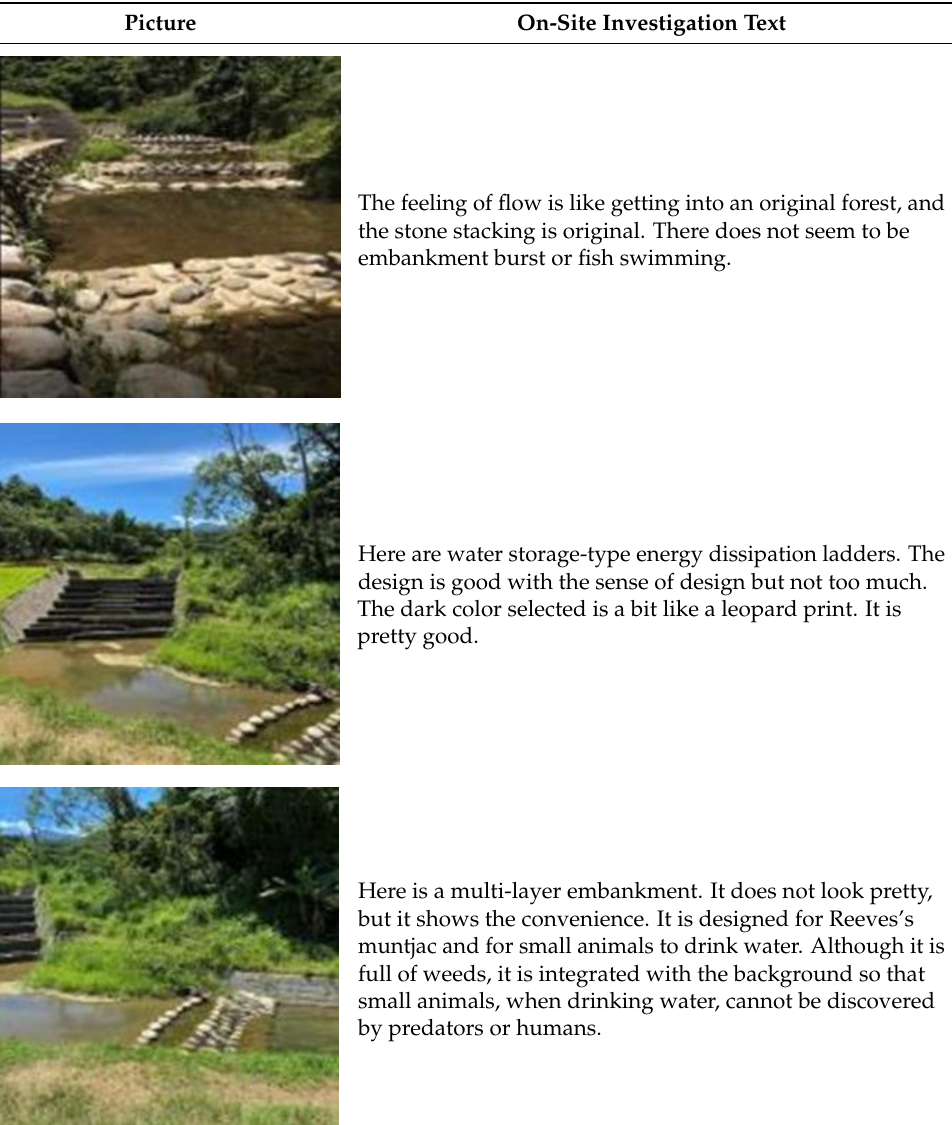
Table 4. On-site investigation of the “Renovation Project of Sijiaolin Stream”.